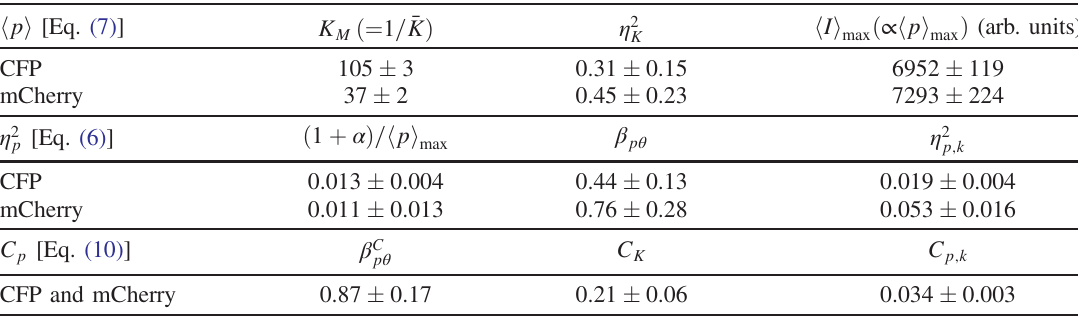
TABLE I. Optimized values with the standard error of the adjustable parameters in Eqs. (6), (7), and (10) for our synthetic E. coli system with T7 RNAP transcription machinery. Each of the equations is compared with 54 experimental data points to extract the values of the three parameters in each row. Details of the data analysis are presented in Appendix I. The unit of K in Table I is RNAP copy number. For E. coli , one copy number per cell M corresponds to 1 nM approximately. The optimized values of K are comparable to the previously reported M